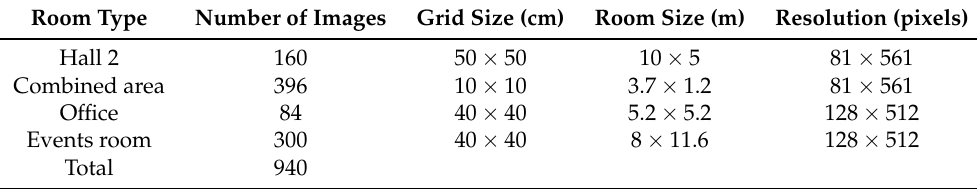
Table 5. Main features of the additional sets of images used to perform the final